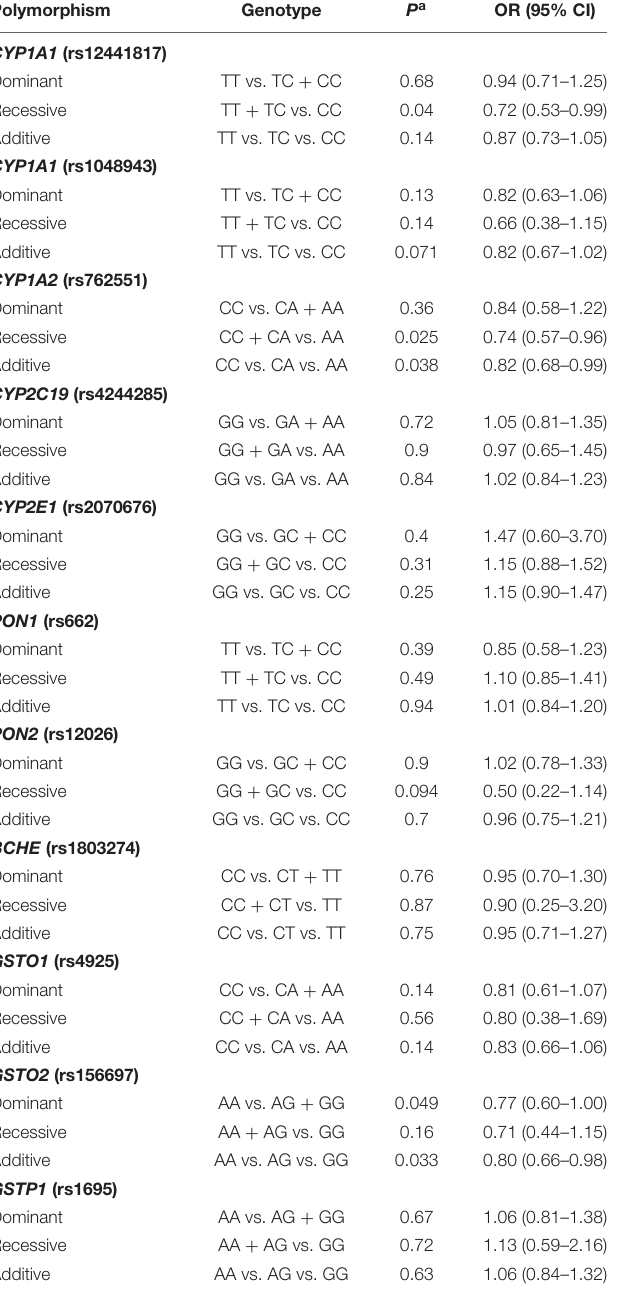
TABLE 2 | Association analyses with PD using dominant, recessive, and additive models. Polymorphism